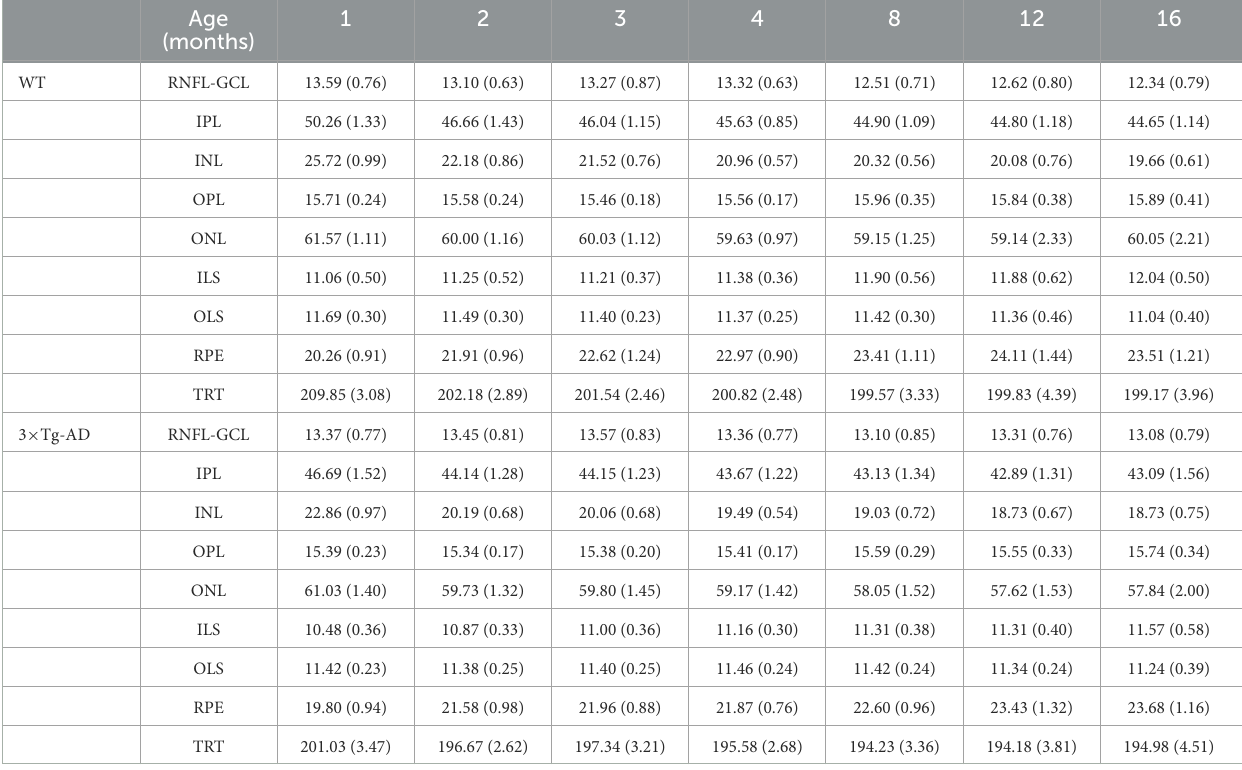
TABLE 3 Longitudinal thickness values, in µ m, for both eyes of wild-type (WT) and the triple transgenic Alzheimer’s disease (3xTg-AD) mice. Age (months)